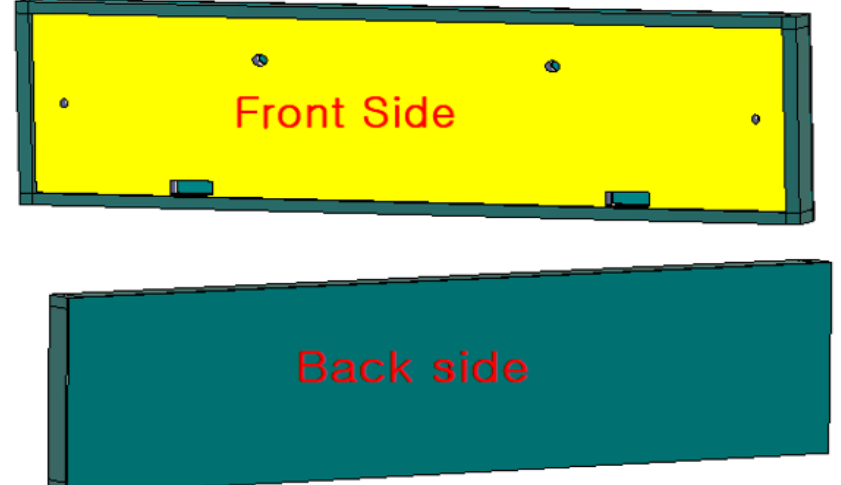
Figure 3. Front and back side of license plate RFID tag antenna with bumper.